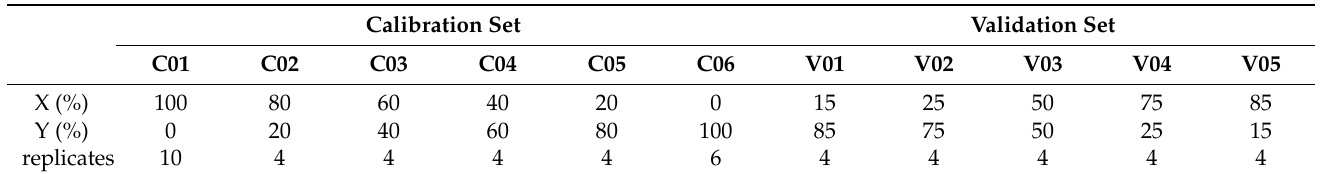
Table 1. Concentration levels designed for paprika adulteration cases in calibration and validation sets, where X is the pure paprika samples and Y is the adulterated